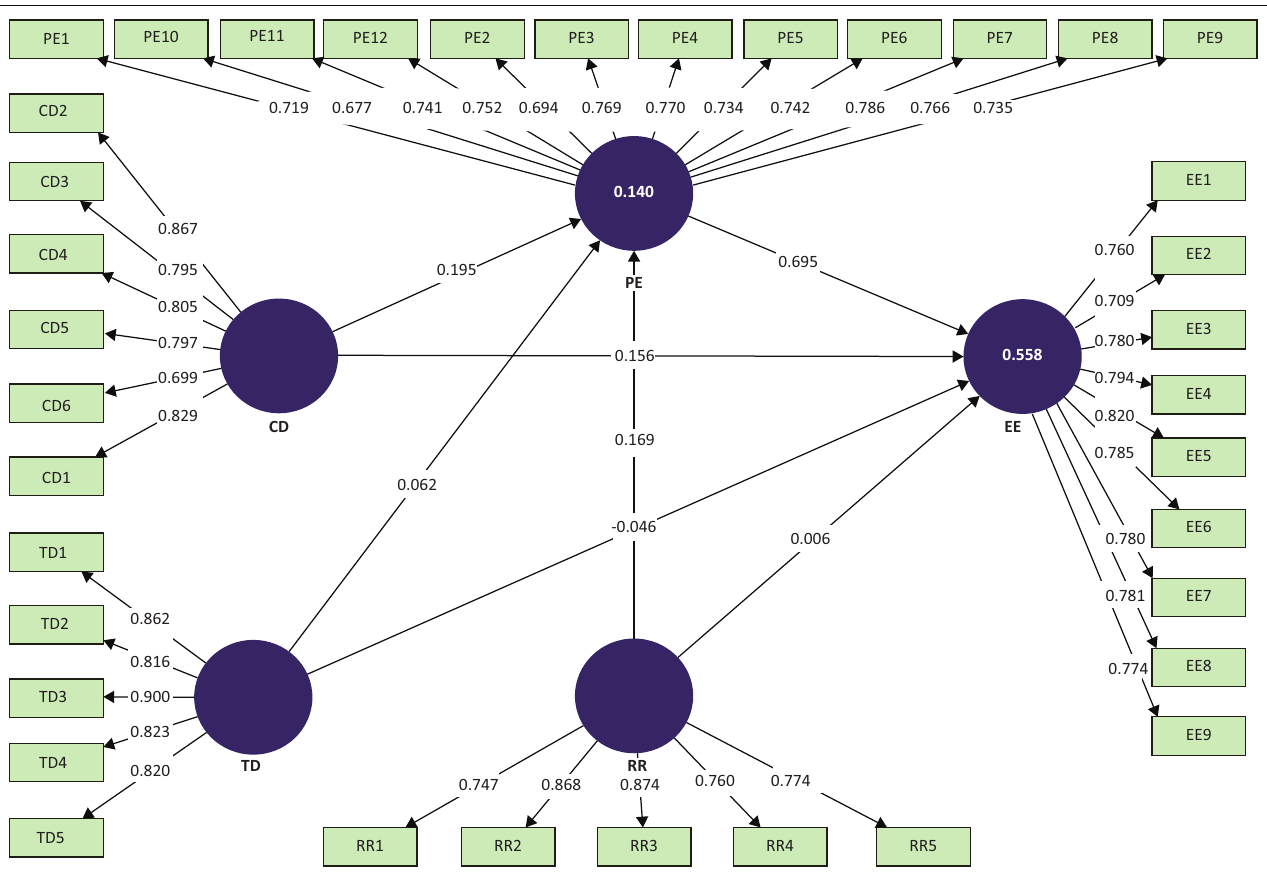
RR, rewards and recognition; TD, Training & Development; EE, Employee Engagement; PE, Psychological Empowerment; CD, Career Development FIGURE 2: Measurement model from partial least squares-structural equation modelling